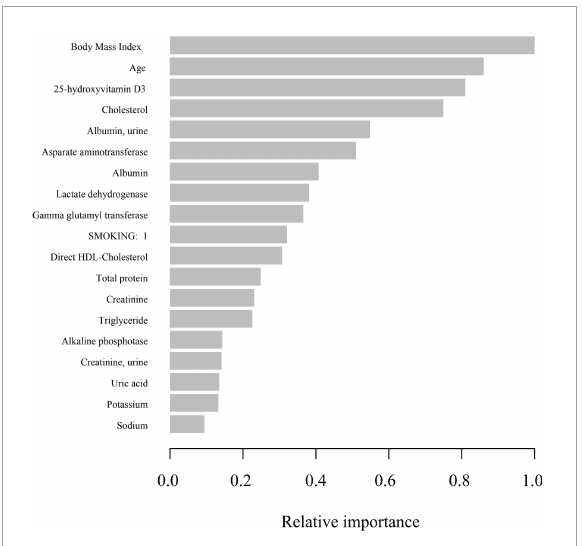
FIGURE4 Relative importance of the selected variables using XGBoost and the corresponding variable importance score. X -axis indicates the importance score, which is the relative number of a variable that is used to distribute the data, Y -axis indicates the selected